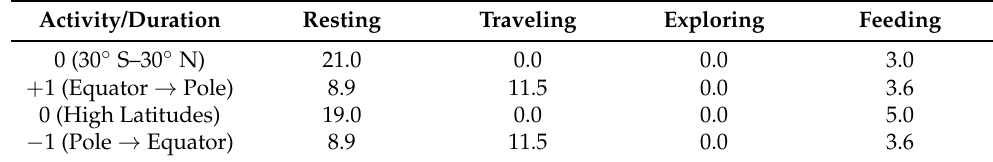
Table 5. Table of the cumulative daily behavior period duration, τ b